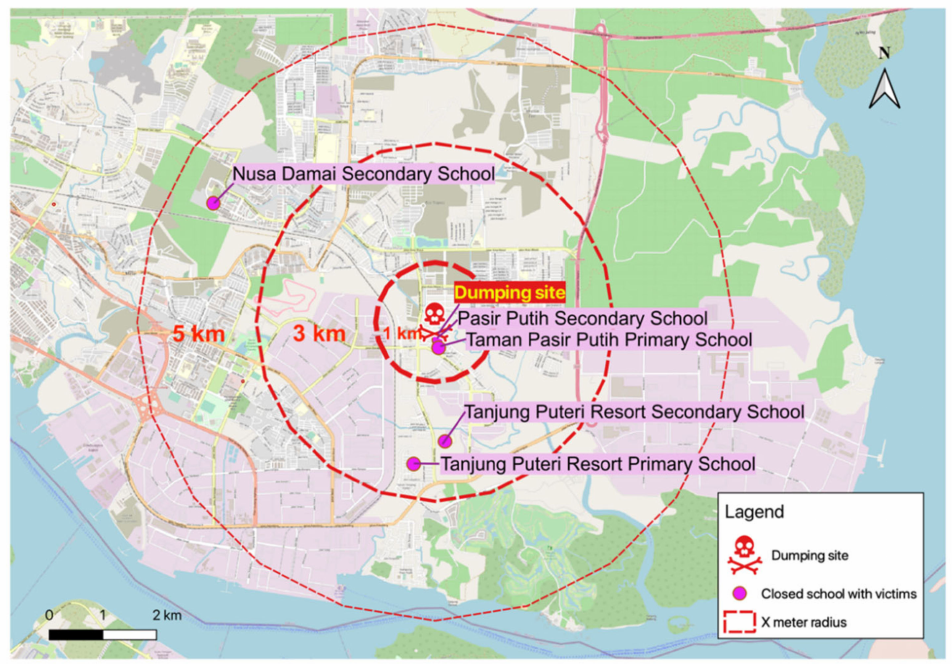
Figure 4. Location of the dumping site and schools